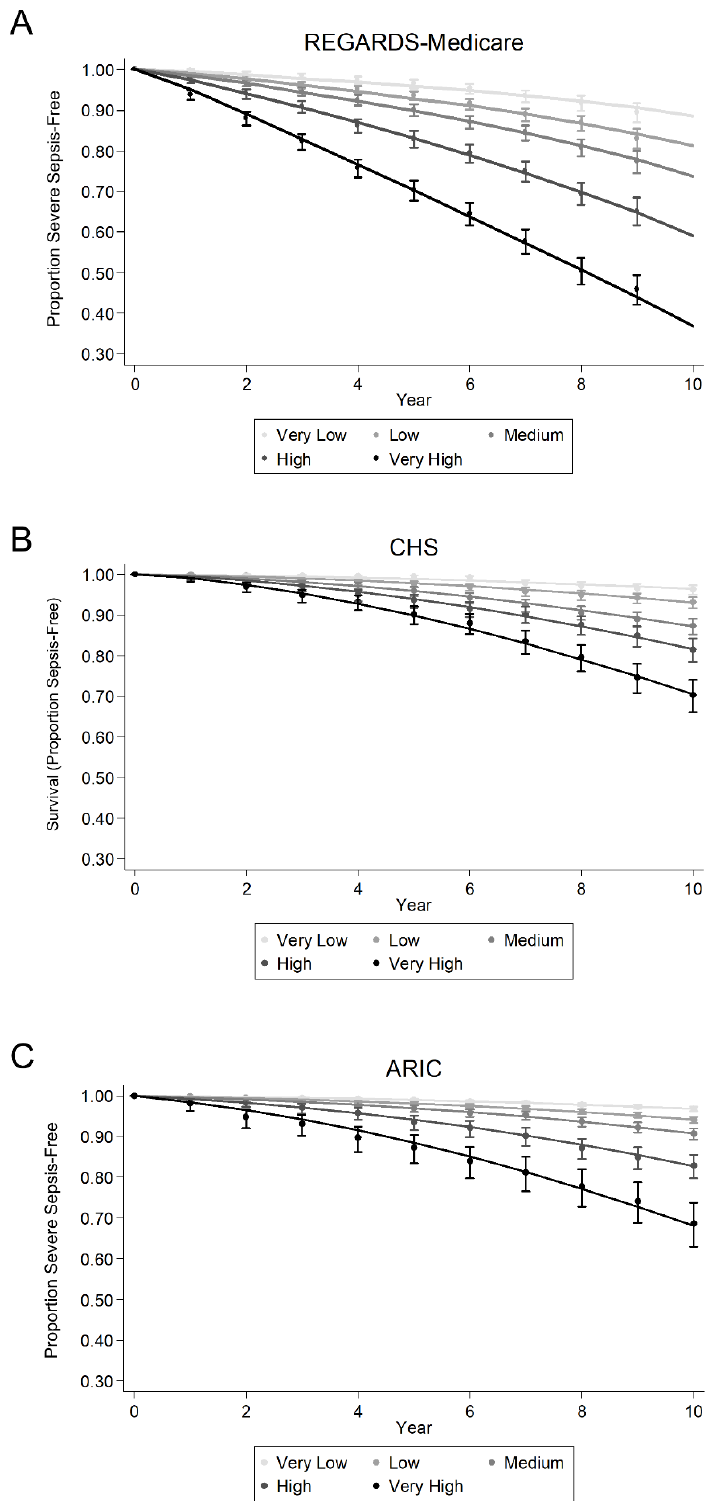
Figure 2. Calibration of the REGARDS Severe Sepsis Risk Score in the REGARDS-Medicare ( A ), CHS ( B ) and ARIC ( C ) cohorts. REGARDS = Reasons for Geographic and Racial Differences in Stroke. CHS = Cardiovascular Health Study. ARIC = Atherosclerosis Risk in Communities.